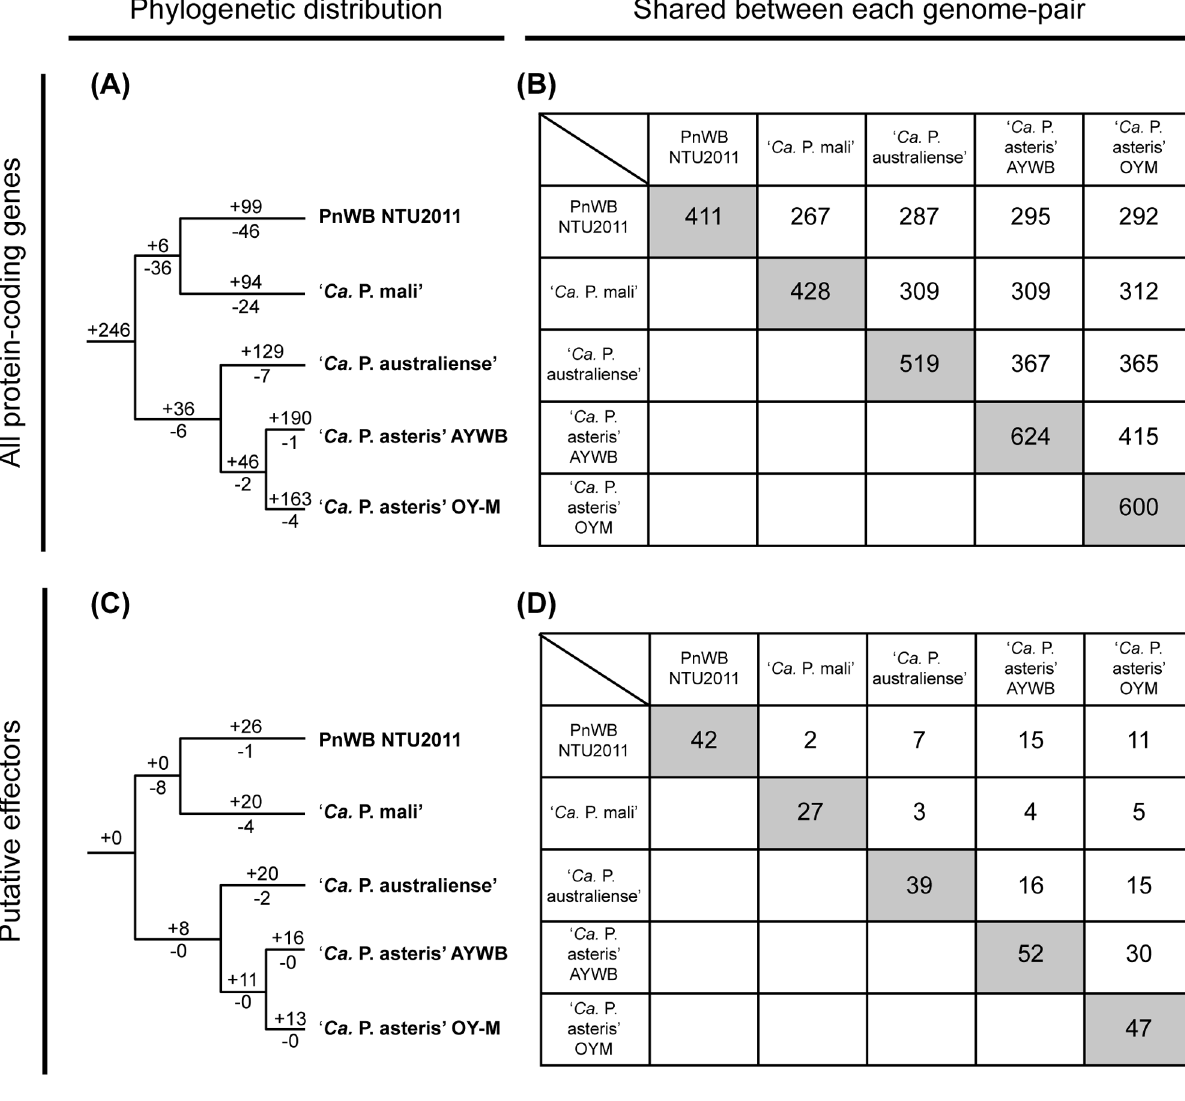
Figure 3. Distribution patterns of homologous gene clusters. Panels (A) and (B) are based on all protein-coding genes, panels (C) and (D) are based on the putative effectors. Panels (A) and (C) illustrate the phylogenetic distribution patterns of homologous gene clusters. The numbers above a branch and preceded by a ‘ + ’ sign indicate the number of clusters that are uniquely present in all daughter lineages, the numbers below a branch and preceded by a ‘ 2 ’ sign indicate the number of clusters that are uniquely absent. For example, in panel (A) PnWB NTU2011 and ‘ Ca. P. mali’ share six homologous gene clusters that are not found in any of the other three phytoplasma genomes; similarly, 36 clusters are absent in both PnWB NTU2011 and ‘ Ca. P. mali’ but are shared by the other three phytoplasma genomes. Panels (B) and (D) illustrate the number of homologous gene clusters shared between each genome-pair, numbers on the diagonal indicate the number of clusters found in each individual genome.